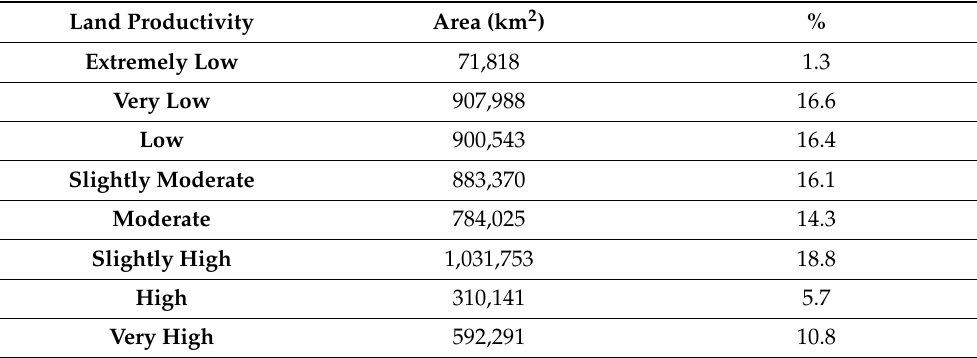
Table 15. The regional spatial extent of land productivity in the studied